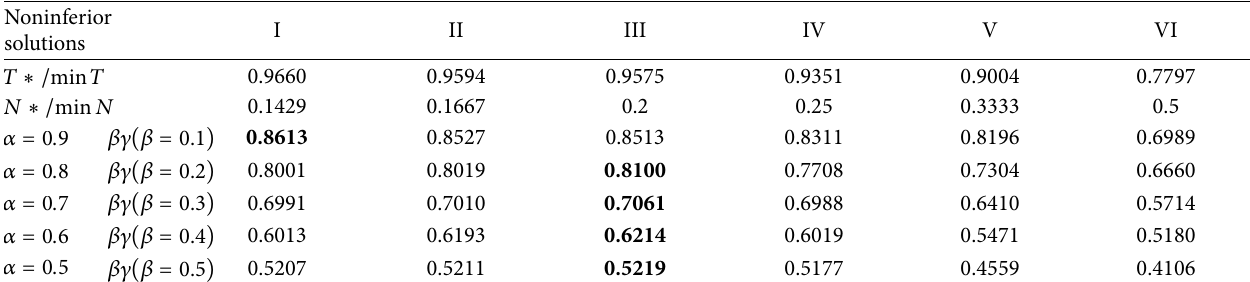
) for various 𝑇𝑁 𝐸